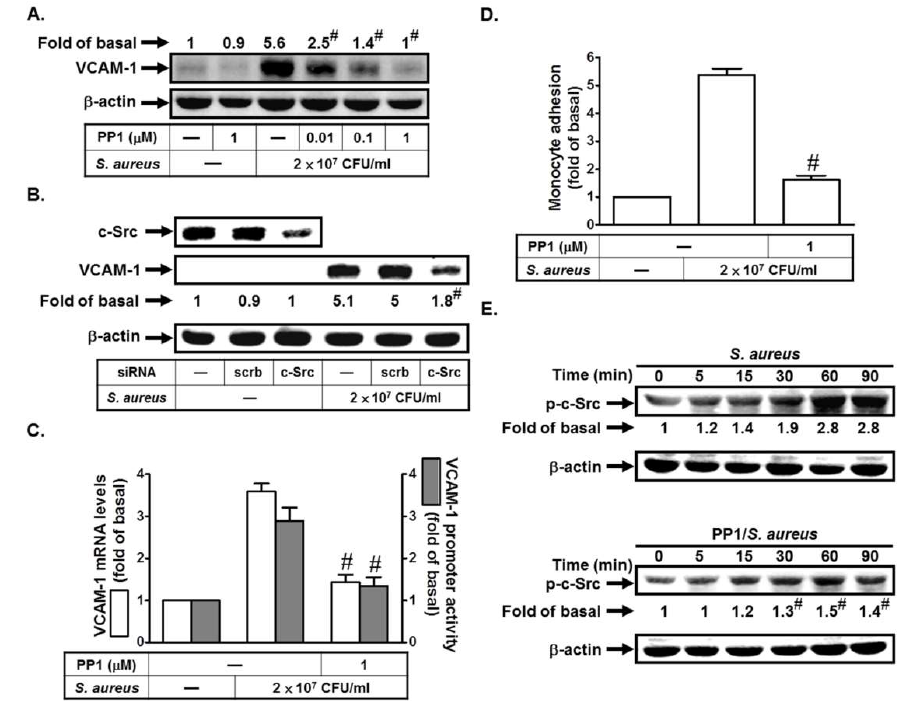
Figure 1. S. aureus induces vascular cell adhesion molecule-1 (VCAM-1) expression in human lung epithelial cells (HPAEpiCs) via c-Src. ( A ) Cells were pretreated with PP1 for 1 h, and then treated with S. aureus for 24 h. The protein levels of VCAM-1 were determined by Western blot. ( B ) Cells were transfected with scrambled or c-Src siRNA, and then incubated with S. aureus for 24 h. The protein levels of c-Src and VCAM-1 were determined by Western blot. ( C , D ) Cells were pretreated with PP1 for 1 h, and then treated with S. aureus for 4 h, 6 h, or 24 h. The mRNA levels and promoter activity of VCAM-1 were determined by real-time PCR and promoter activity ( C ). The THP-1 cells (a human monocytic cell line) adherence was measured ( D ). ( E ) Cells were pretreated without or with PP1 for 1 h, and then incubated with S. aureus for the indicated times. The expression of phospho-c-Src was determined by Western blot. n = 3–4, # p < 0.01, as compared with the cells exposed to S. aureus